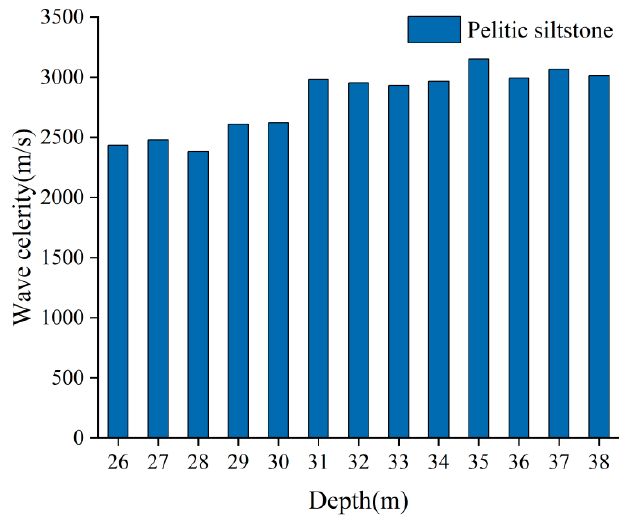
Figure 4. Borehole acoustic wave velocity at each